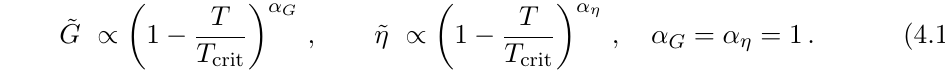
Figure 7 . The reduced shear elastic modulus ~ G = 16 (cid:25)G N G=k 4 (left panel) and the reduced shear viscosity ~ (cid:17) = (4 (cid:25)(cid:17)= S (cid:0) 1) (right panel) as a functions of T=(cid:22) close to criticality at (cid:12)xed value k and they correspond to a (cid:13)uid state which saturates the KSS bound and has no shear elastic